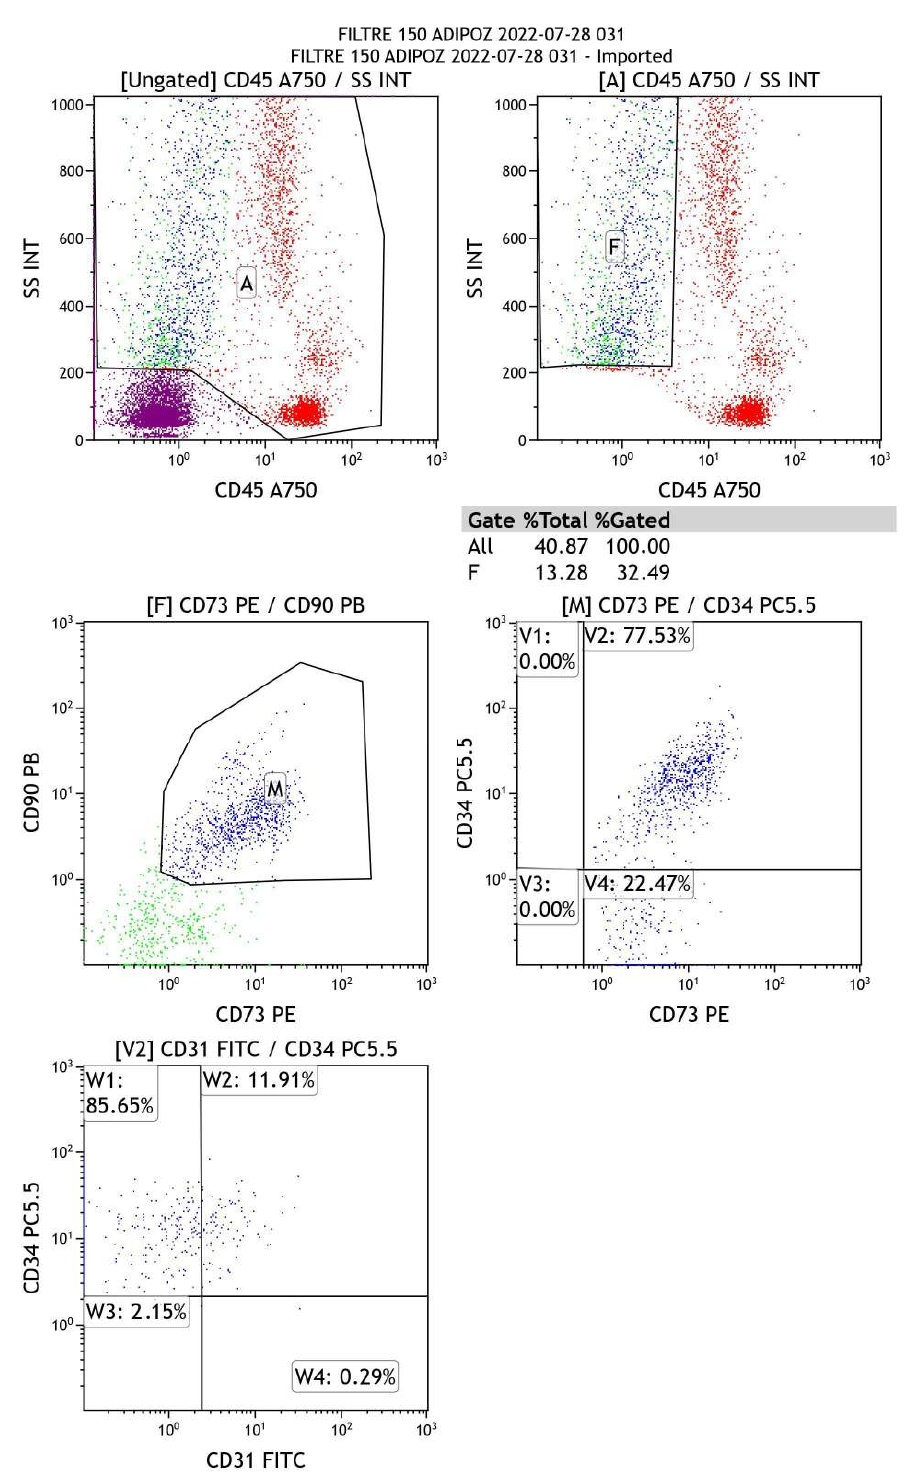
Figure 4. Flow cytometry analysis for AD-tSVF after filtration reveals cells in the composition are of stem cell nature.